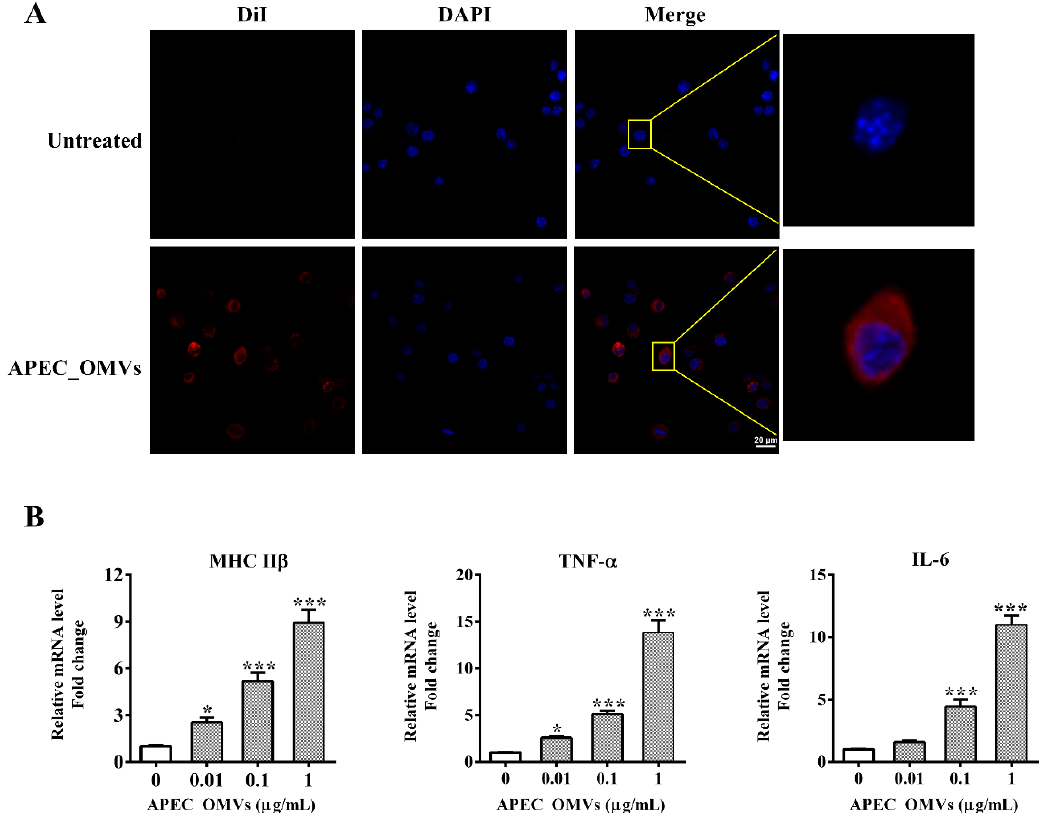
Figure 5. Innate immune responses induced by APEC_OMVs in chicken macrophages in vitro. ( A ) Visualization of internalization of APEC_OMVs by chicken HD11 macrophages using a confocal microscope. Row 1 was a non-stimulated treatment. Row 2 was stimulated with 5 µ g / mL of DiI-labeled APEC_OMVs (red signal) for 6 h at 37 ◦ C followed by cell nucleus staining with 10 µ g / mL of DAPI (blue signal). ( B ) qRT-PCR analysis for the expression of MHC II β , TNF- α and IL-6 in HD11 cells stimulated with various concentrations of APEC_OMVs for 16 h. Results are representatives of three independent experiments and expressed as mean ± SE. * p < 0.05; ** p < 0.01; *** p < 0.001, versus the control.